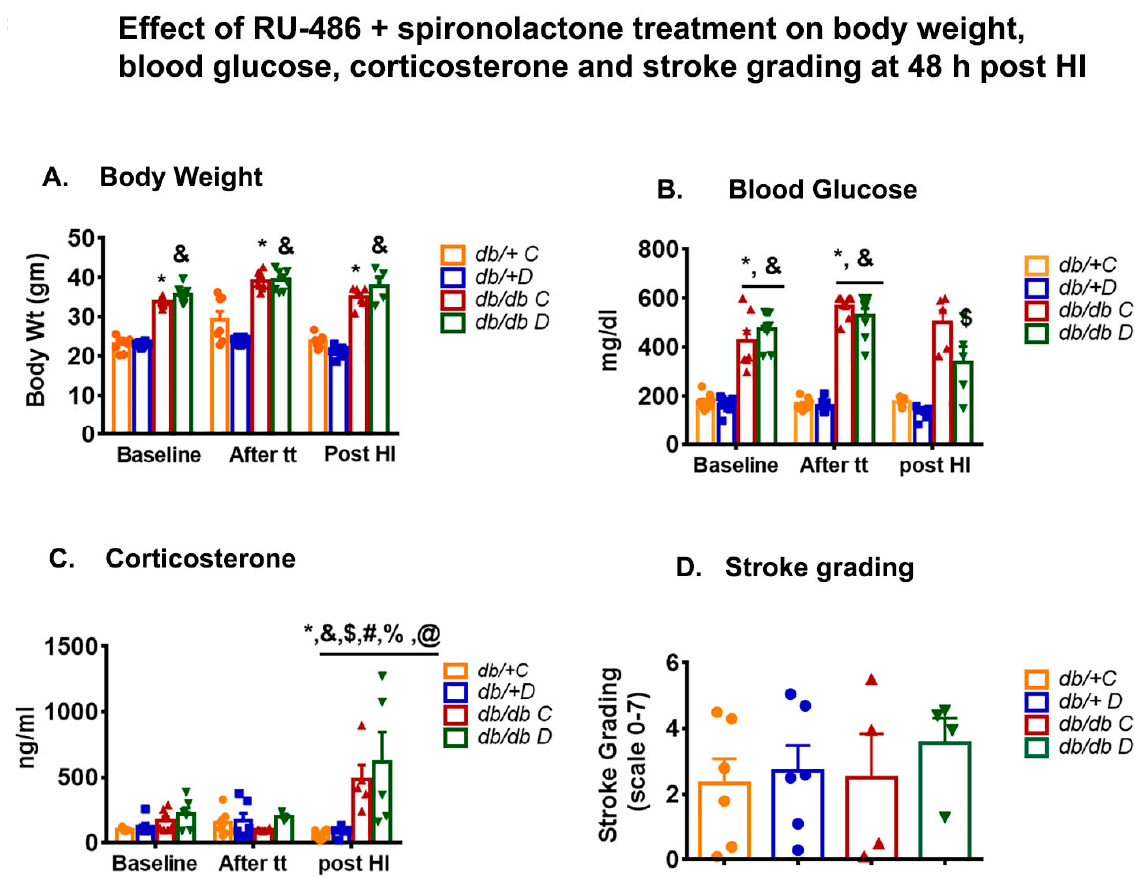
Figure 2. ( A – C ) shows the effect of RU-486 + spironolactone treatment on body weight, blood glucose and corticosterone at baseline, one week after treatment (tt) and 48 h post-HI compared with their vehicle control. Values were shown as mean ± SEM and significance were set at p < 0.05. db/+ C: vehicle control ( n = 5 to 8), db/ +D : RU-486 + spironolactone treatment ( n = 5 to 8), db/db C: vehicle control ( n = 5 to 8), db/db D: RU-486 + spironolactone treatment ( n = 3 to 8), db/dbC- tt: after 1week vehicle treatment, db/db D-tt: after 1 week of drug treatment. * p < 0.05 vs. db/+ C baseline: and & p < 0.05 vs. db/+ D baseline, # p < 0.05 vs. db/db C baseline: $ p < 0.05 vs. db/db D baseline, % p < 0.05 vs. db/dbC- tt: @ p < 0.05 vs. db/db D-tt. ( D ) shows the effect of RU-486 + spironolactone treatment on infarct